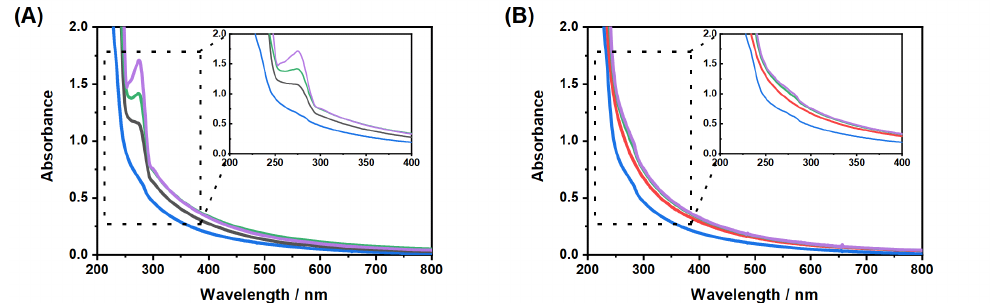
Figure 7. UV/Vis measurements for the investigation of the loading (20°C) and release (40°C) of CBD by the copolymer microgel particles. The measurements were performed after the incorporation ( A ) and release ( B ) of CBD in EtOH in a 0.3wt% microgel suspension. The initial concentrations of CBD were 0.5mg/mL (black), 15mg/mL (green) and 25mg/mL (purple) (1mg/mL and 5mg/mL are not displayed for the sake of clarity of the presentation). The absorbance spectrum of a pure microgel suspension is given for comparison